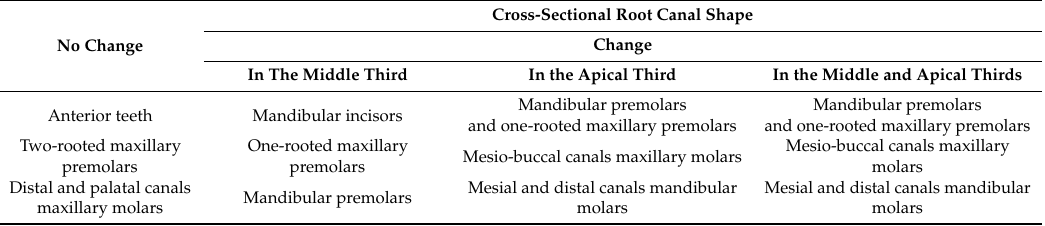
Table 1. Classification of cross-sectional root canal shape according to teeth.